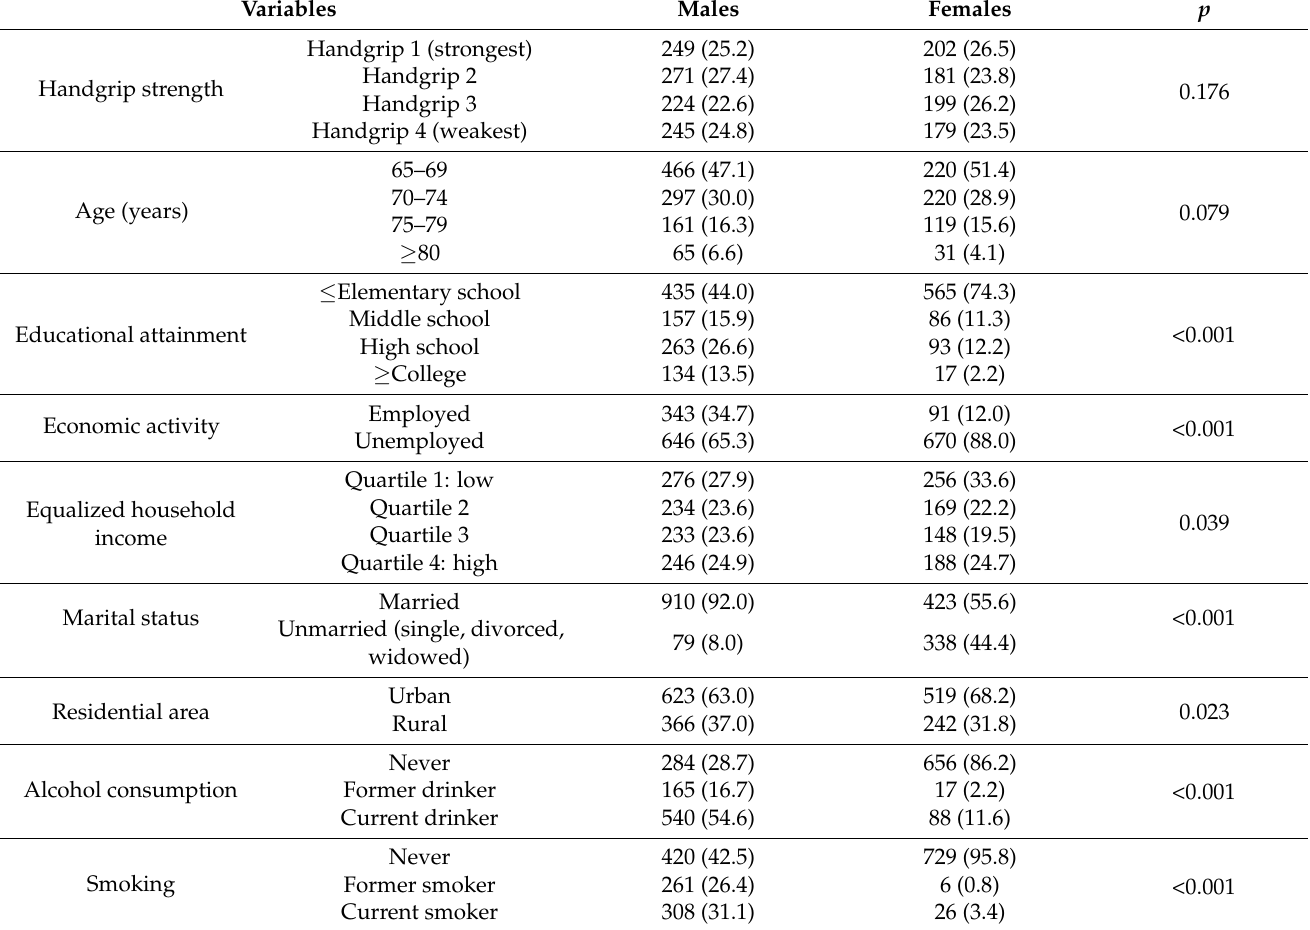
Table 2. Baseline characteristics of the study participants according to